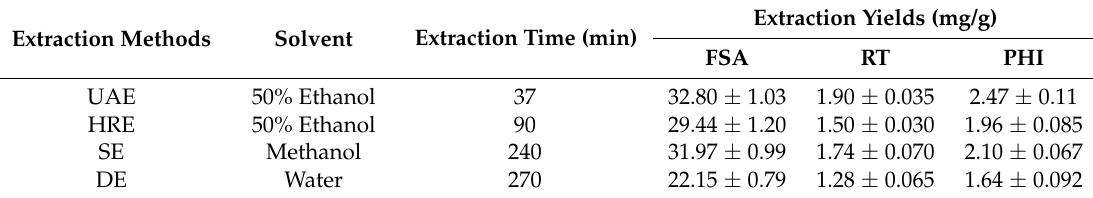
Table 3. Comparison of UAE with heat reflux extraction (HRE), Soxhlet extraction (SE) and decocting extraction (DE) on the extraction yields of FSA, RT and